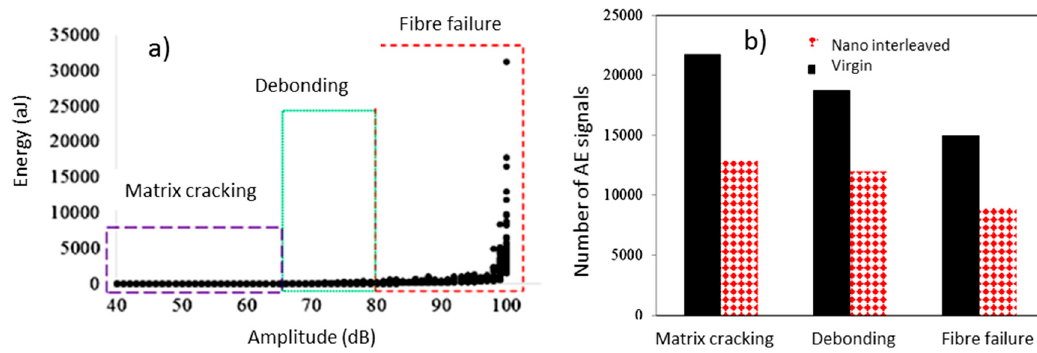
Figure 6. ( a ) Classification of the AE data by energy and amplitude levels; ( b ) number of the AE signals associated with different damage modes for the static loading.